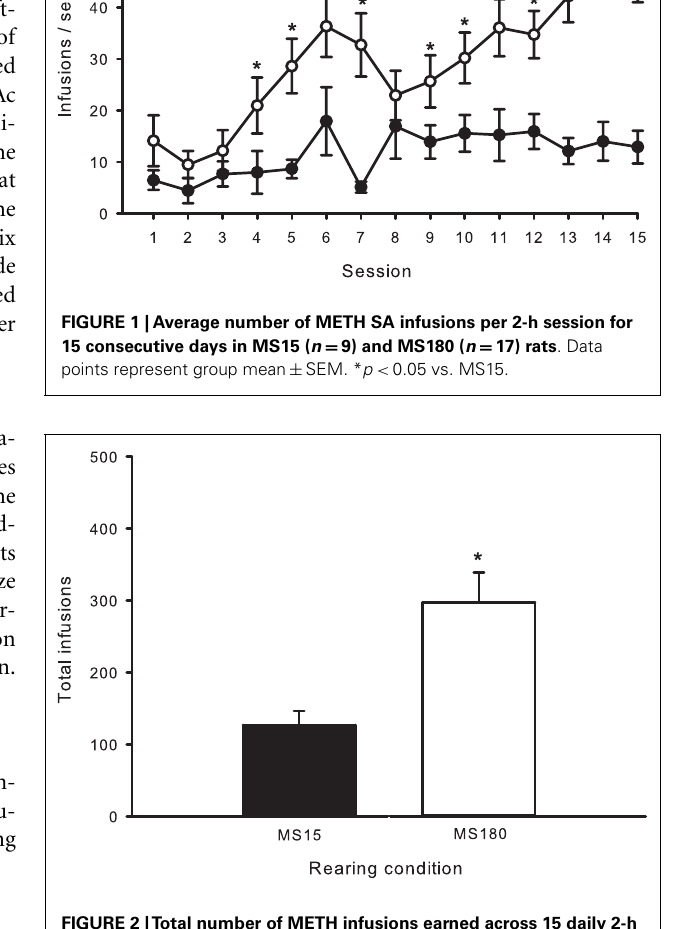
FIGURE 2 |Total number of METH infusions earned across 15 daily 2-h sessions in MS15 ( n = 9) and MS180 ( n = 17) rats . Data points represent group mean ± SEM. * p < 0.05 vs.